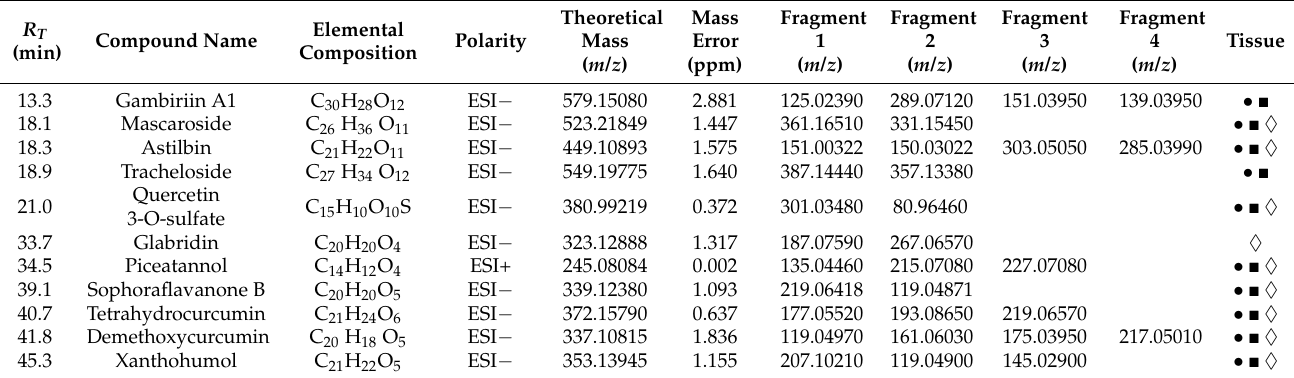
Table 3. Average retention times ( R T ) and m/z ions of the non-target compounds in the Orbitrap system for P. oceanica . Compounds detected in P. oceanica roots (●) rhizomes ( ■ ), and/or leaves (◊).